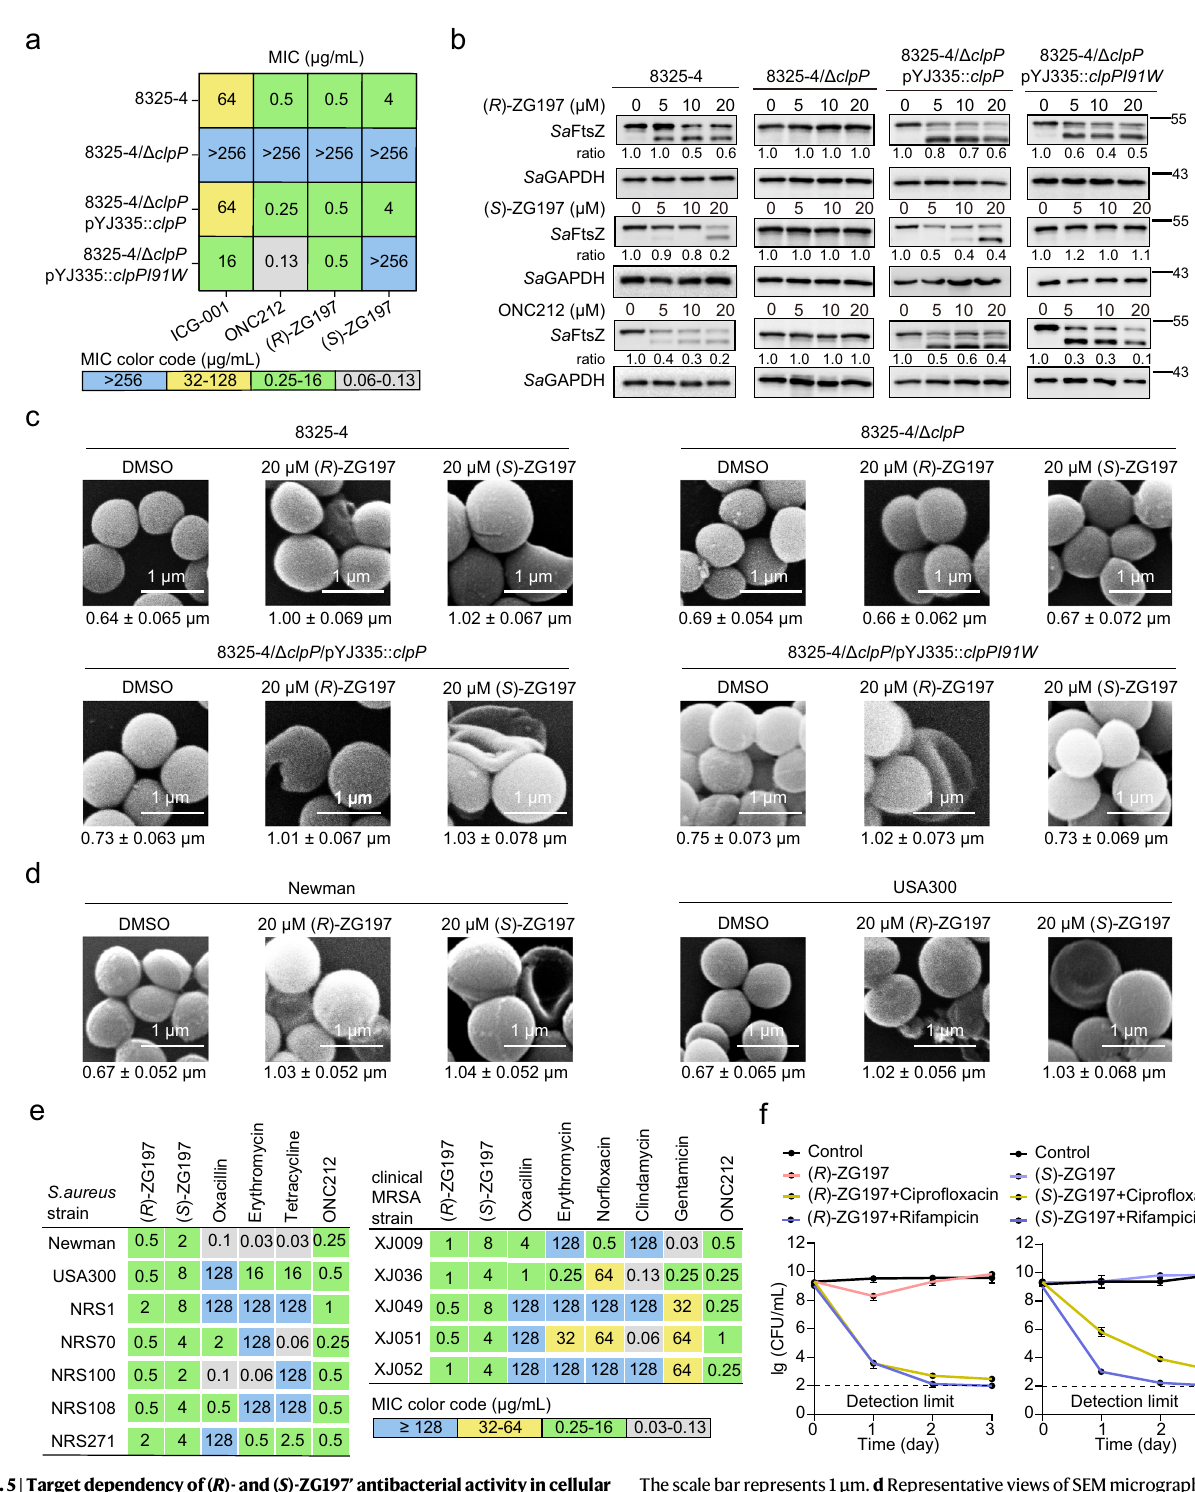
Thescalebarrepresents1 μ m. d RepresentativeviewsofSEMmicrographsshowing the effect of 20 µ M ( R )- and ( S )-ZG197 on cell division of Newman and USA300 strains. The scale bar represents 1 μ m. e Determination of MIC of the Sa ClpP activators against the growth of a panel of S. aureus strains. ( R )- and ( S )- ZG197, ONC212, and the clinic antibiotics oxacillin, tetracycline, erythromycin, nor fl oxacin, clindamycin, and gentamicin were assayed under similar conditions. The experiments were performed in triplicates. f Bactericidal effect of ( R )- and ( S )- ZG197 combined therapy on eradicating stationary phase USA300 ( n =3 biologi- cally independent experiments). Cell numbers were recorded in CFU/mL. Data are presented as mean±SD. Source data are provided as a Source Data fi